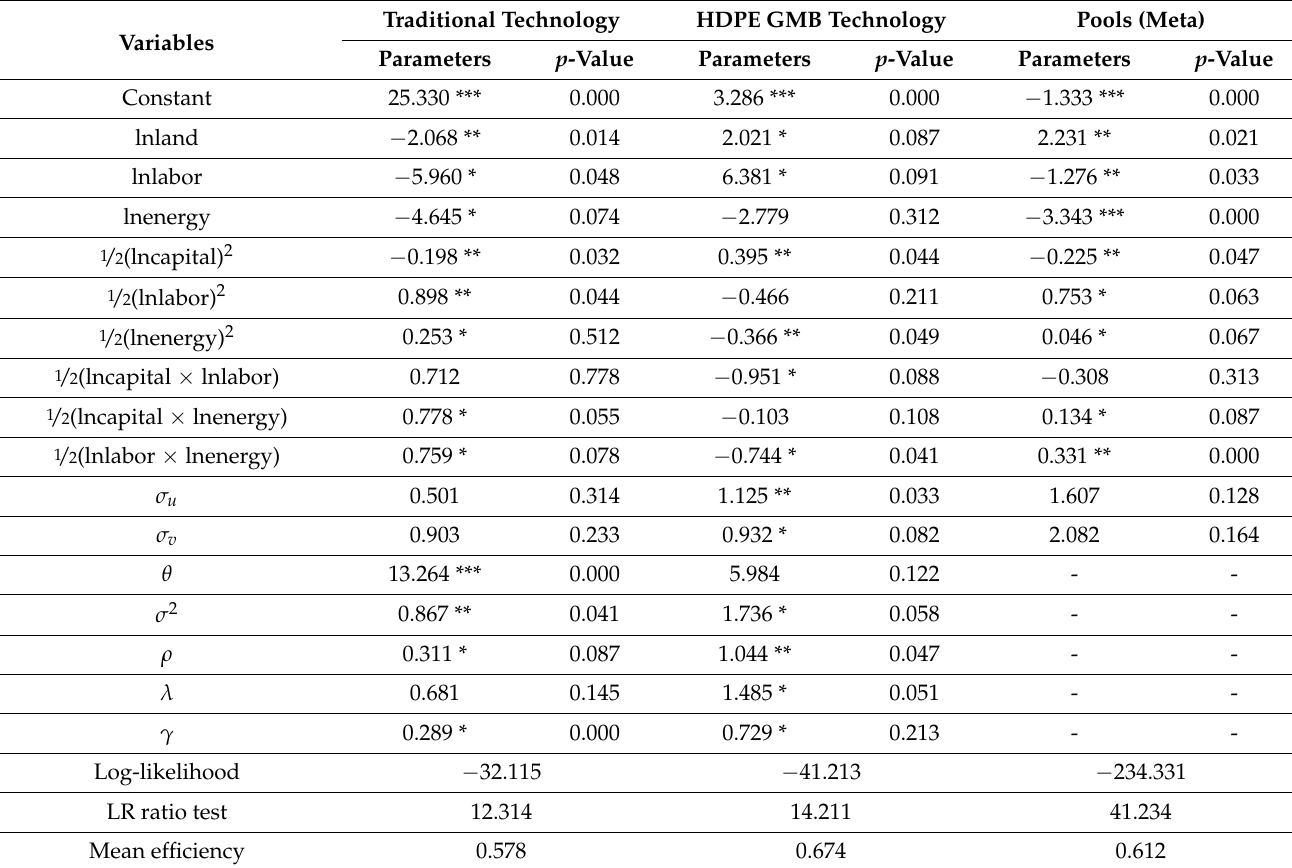
Table 5. Parameter estimates of the Gaussian copula-based meta-frontier production